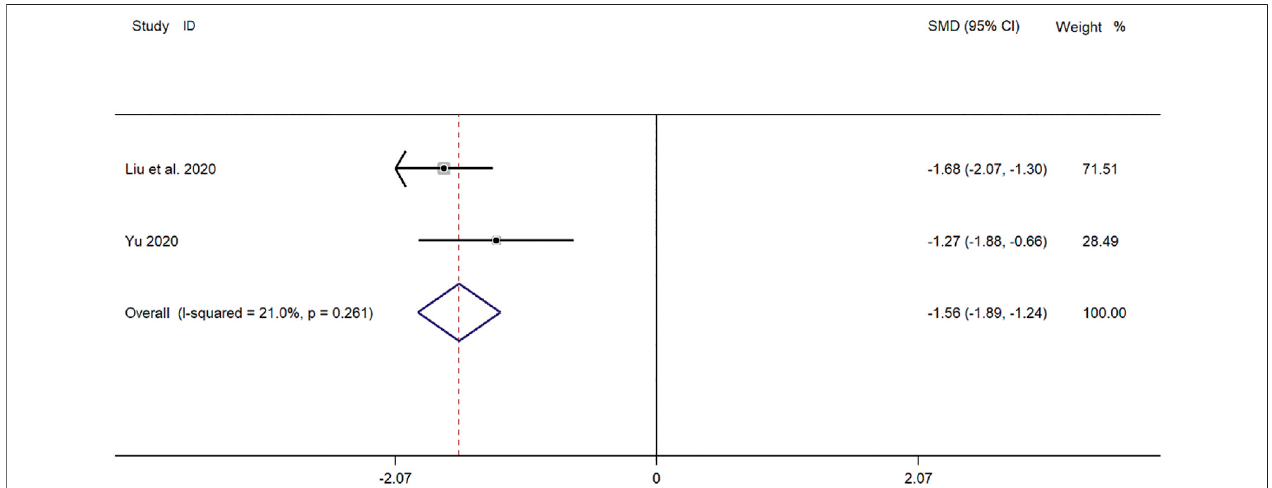
FIGURE 10 | Meta-analysis forest plot comparing TNF- α levels in the experimental and control group.